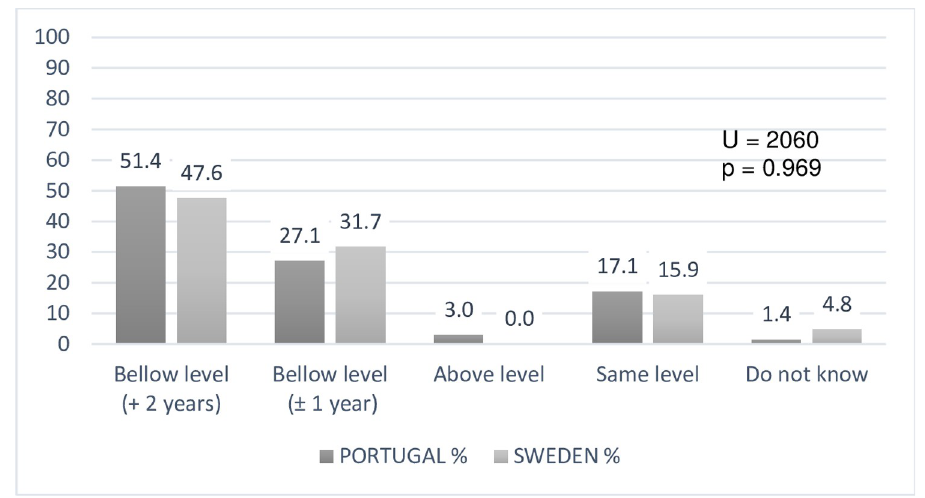
Fig 1. Teachers’ perceptions about the language performance levels of DHH students (N = 133).